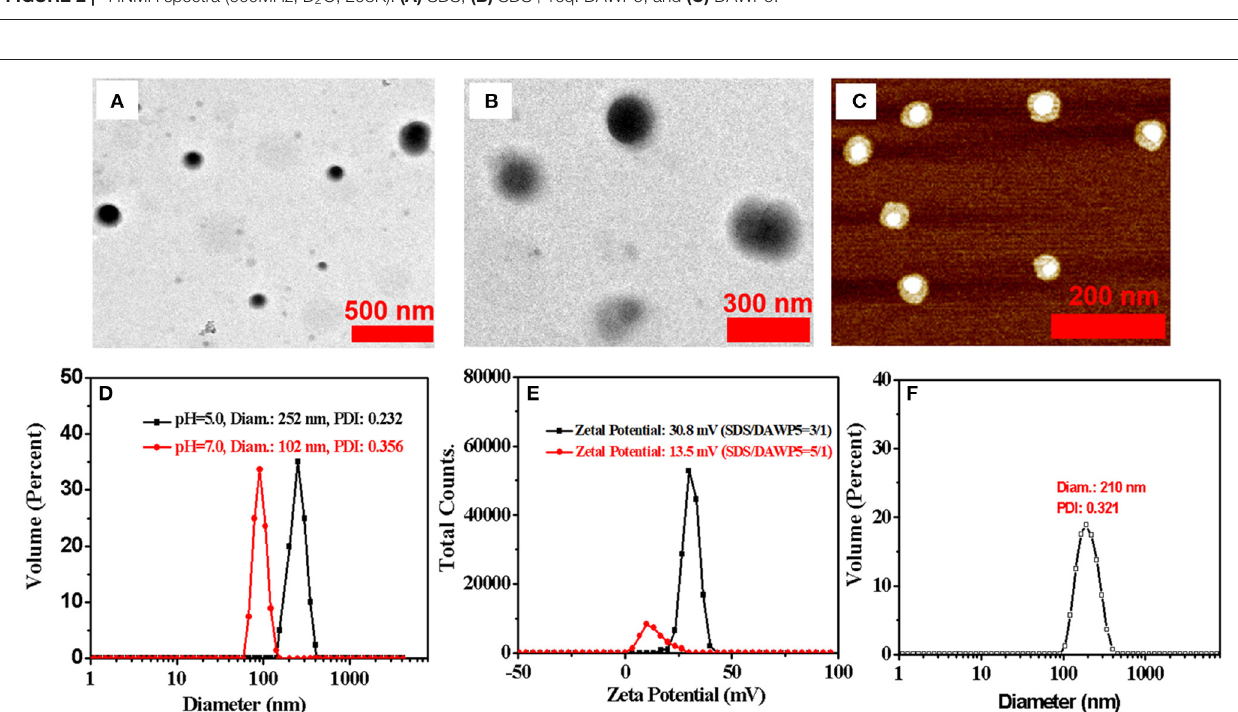
FIGURE 3 | (A) TEM images of SDS ⊂ DAWP5 (3/1) vesicles. (B) TEM images of DOX ⊂ SDS ⊂ DAWP5 (3/1) vesicles. (C) AFM images of SDS ⊂ DAWP5 (3/1) vesicles. (D) DLS data of SDS ⊂ DAWP5 vesicles in different pH condition. (E) zeta potential results of SDS ⊂ DAWP5 vesicles in different molar ratios of SDS:DAWP5 and (F) DLS data of DOX ⊂ SDS ⊂ DAWP5